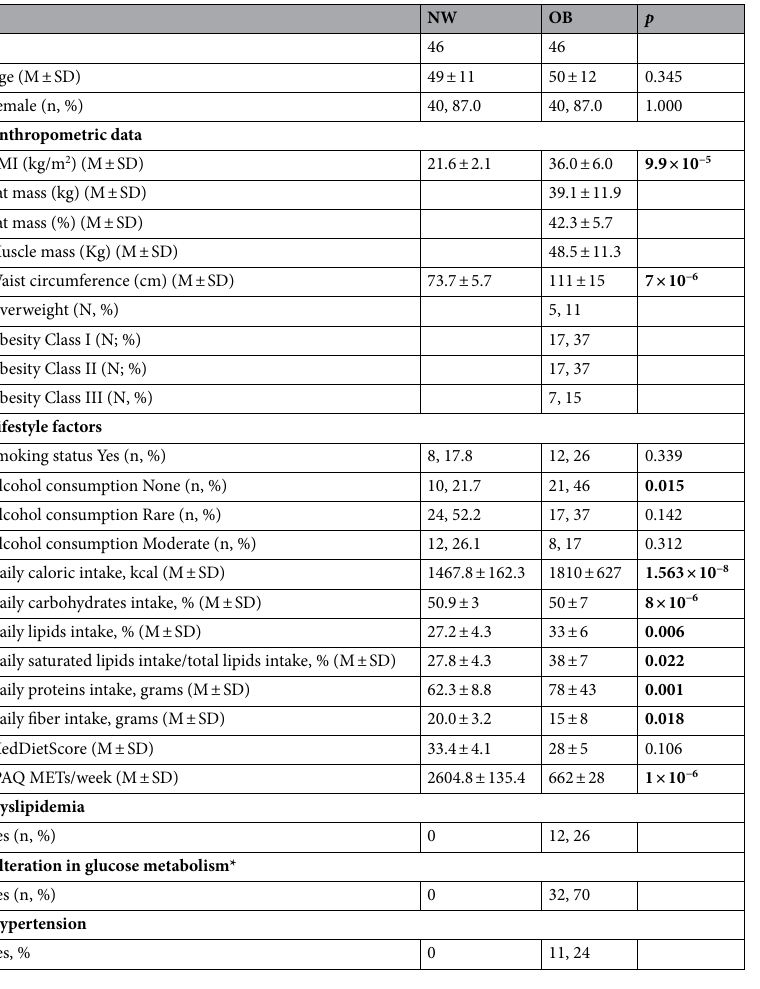
Table 1. Clinical characteristics of study participants. *impaired Fasting Plasma Glucose (FPG) between 100 and 125 mg/dl (6.9 mmol/l), impaired glucose tolerance (IGT) if 2 h post-OGTT plasma glucose